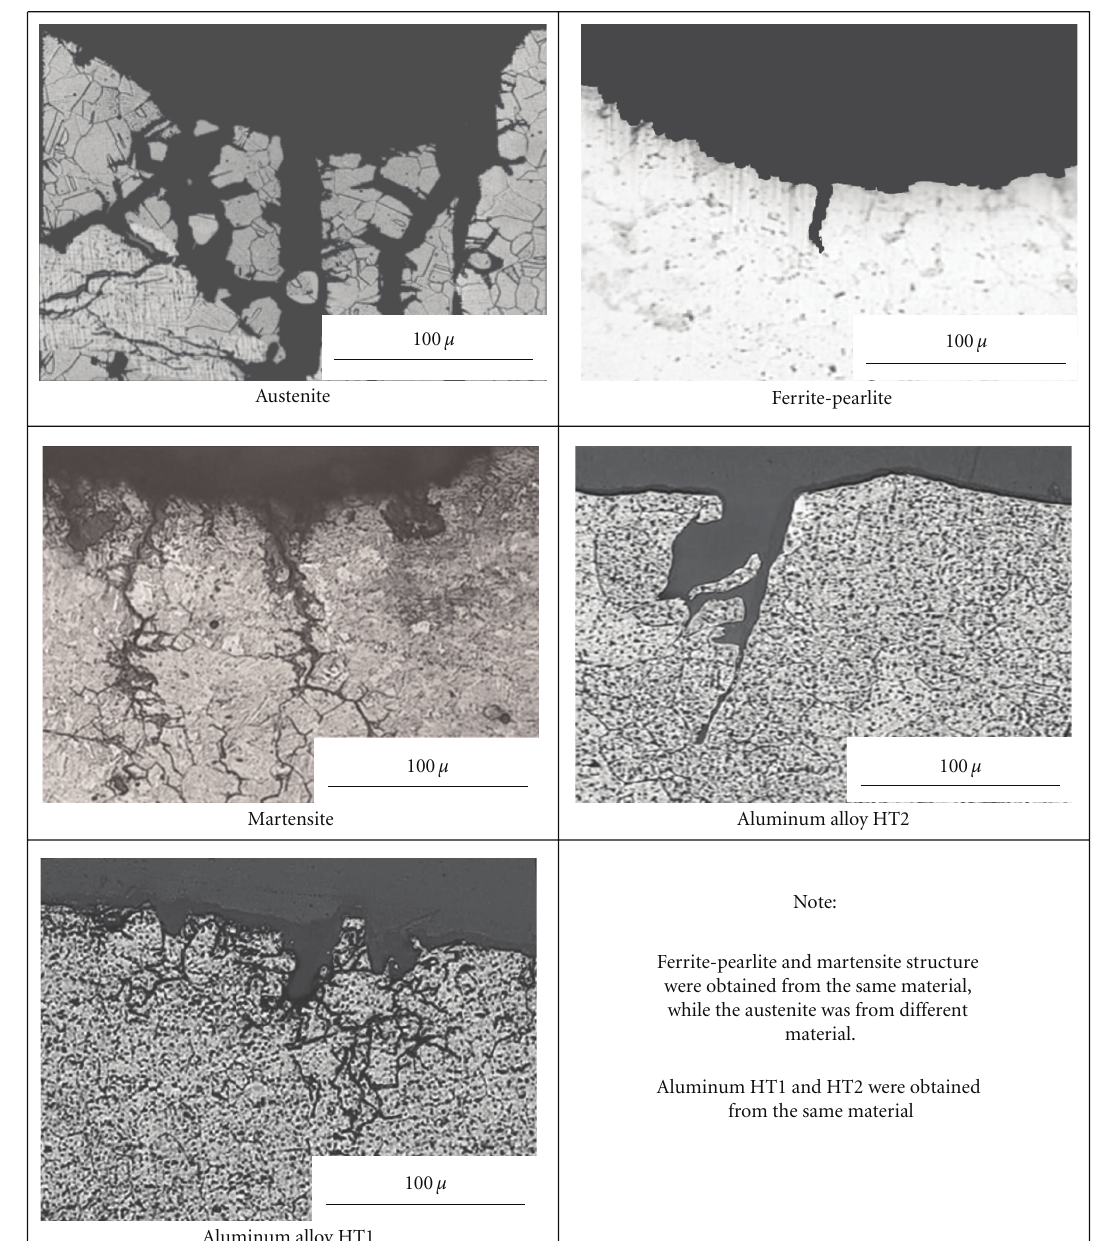
Figure 3: Appearance of the crack shapes for steels and